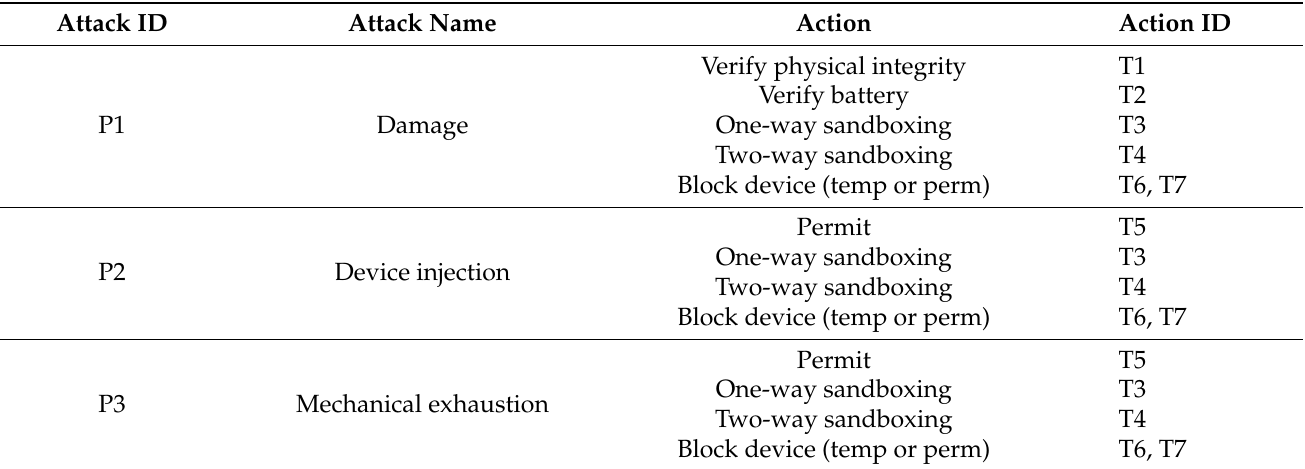
Table 4. Technical actions in physical